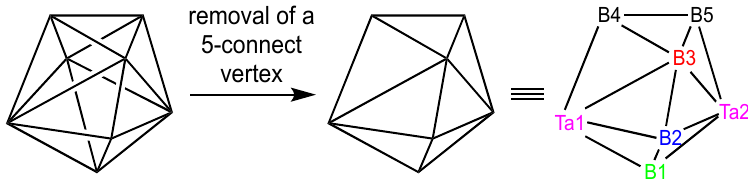
Figure 7. Generation of the cluster structure of cluster 23. Table 4. Skeletal electron pair count (sep), selected structural parameters and 11 B NMR chemical shifts of compounds 23 – 27 .